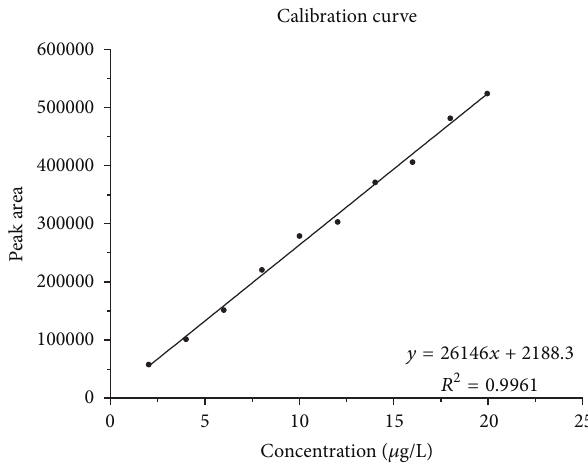
Figure 6: Calibration curve for the determination of tetrachloroe- thene in end-exhaled air; peak area against concentration used.